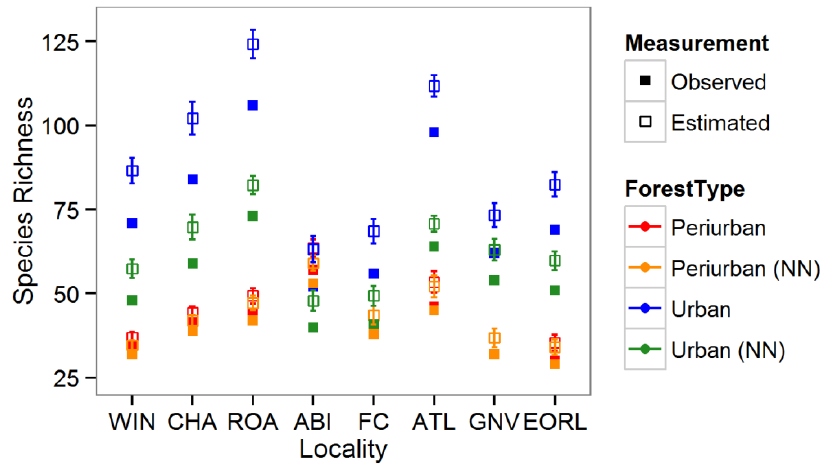
Figure 2. Number of tree species estimated by bootstrap methods and observed via collection. Locations are listed North-South, with the exception of Falls Church which is listed more southerly to reflect its ecological province. Secondary colors (orange and green) represent the species richness of only the native and naturalized species, whereas primary colors (red and blue) include all species. (ATL = Atlanta, GA; CHA = Charlottesville, VA; EORL = East Orlando, FL; FC = Falls Church, VA; GNV = Gainesville, FL; ROA = Roanoke, VA; ABI = Abingdon, VA; WIN = Winchester, VA, NN = Native and Naturalized).